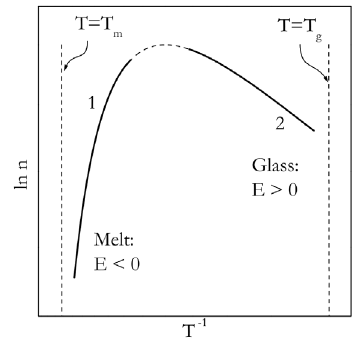
Figure 2. Arrhenius plot for the temperature dependence of the nucleation rate constant (Equation (8)).The bold lines 1 and 2 represent, respectively, crystallization from the melt and glass states. Adapted with permission from Vyazovkin [33]. Copyright Elsevier 2008.